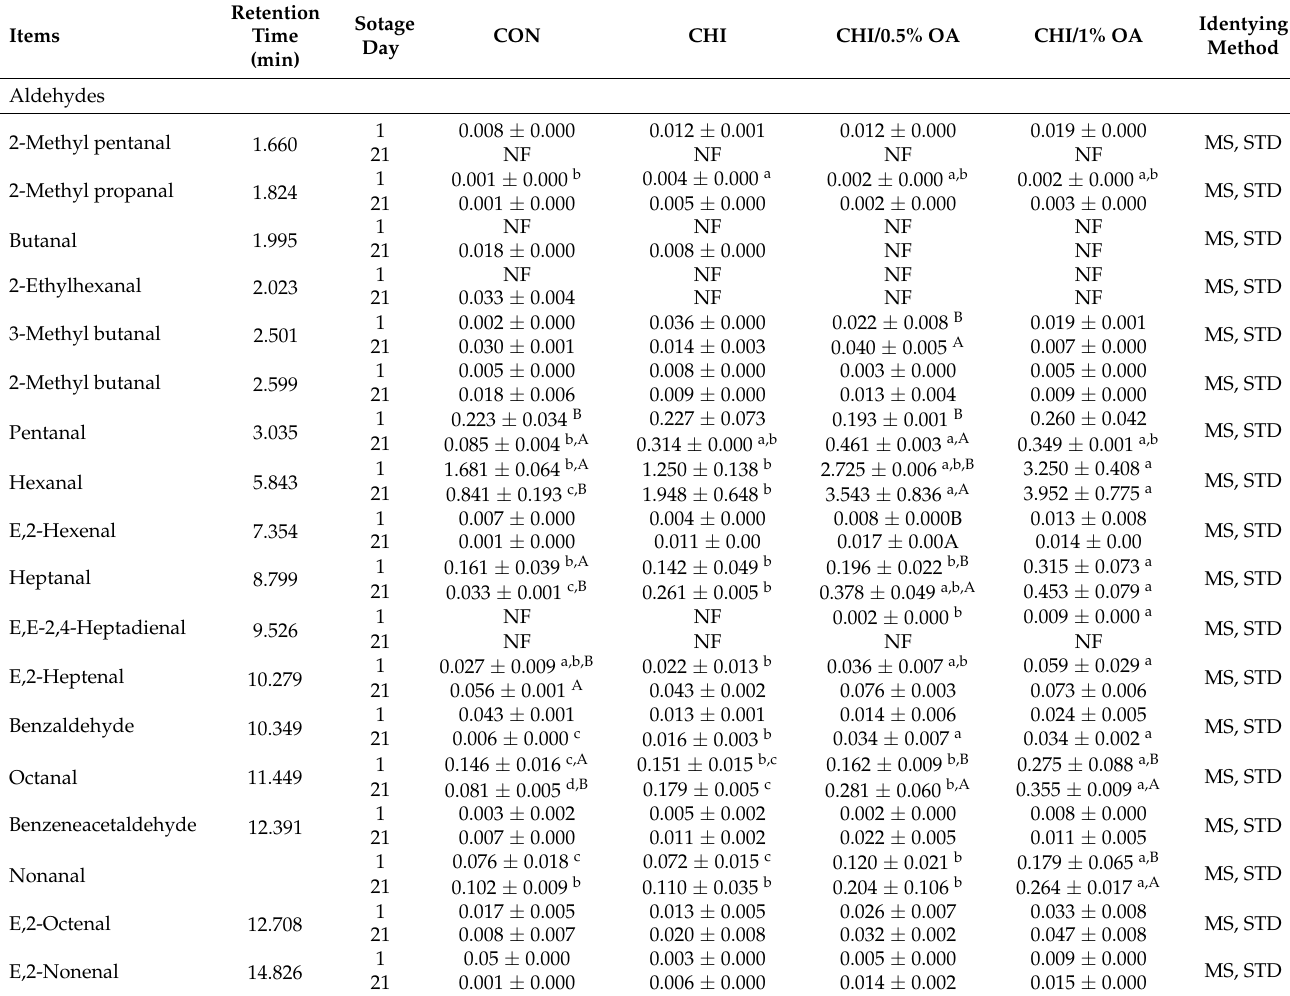
Table 5. Amount ( µ g/g) of volatile aroma compounds in coated pork during